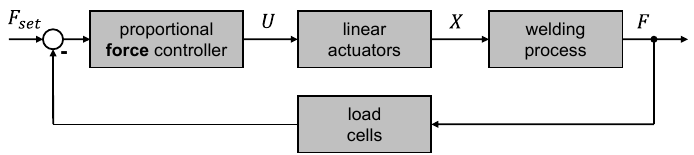
Figure 12. Closed-loop force control.